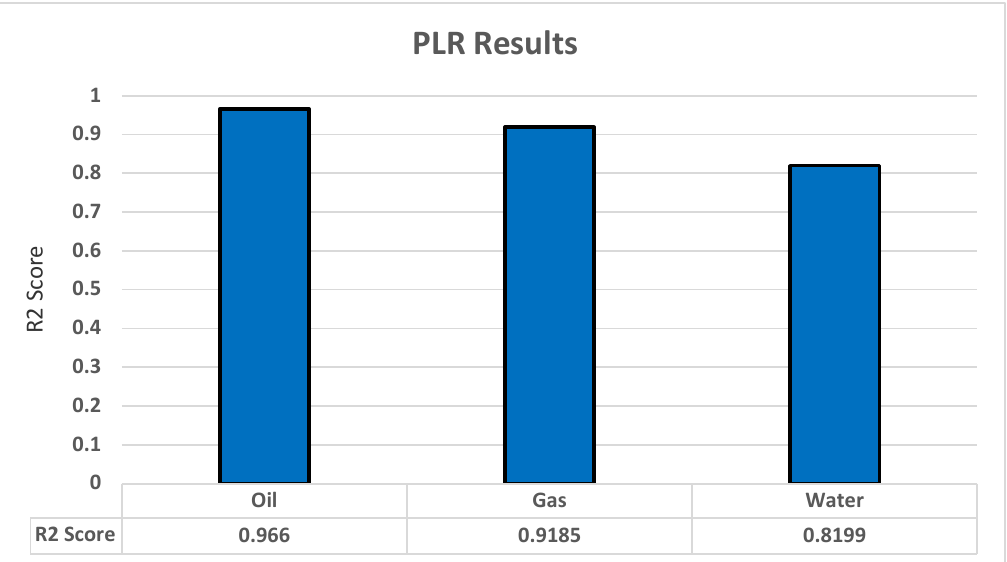
PLR: Comparison of R2 scores for oil, gas, and water Figure 5. PLR’s R2 score results. Figure 5. PLR’s R2 score Figure 5. PLR’s R2 score results.